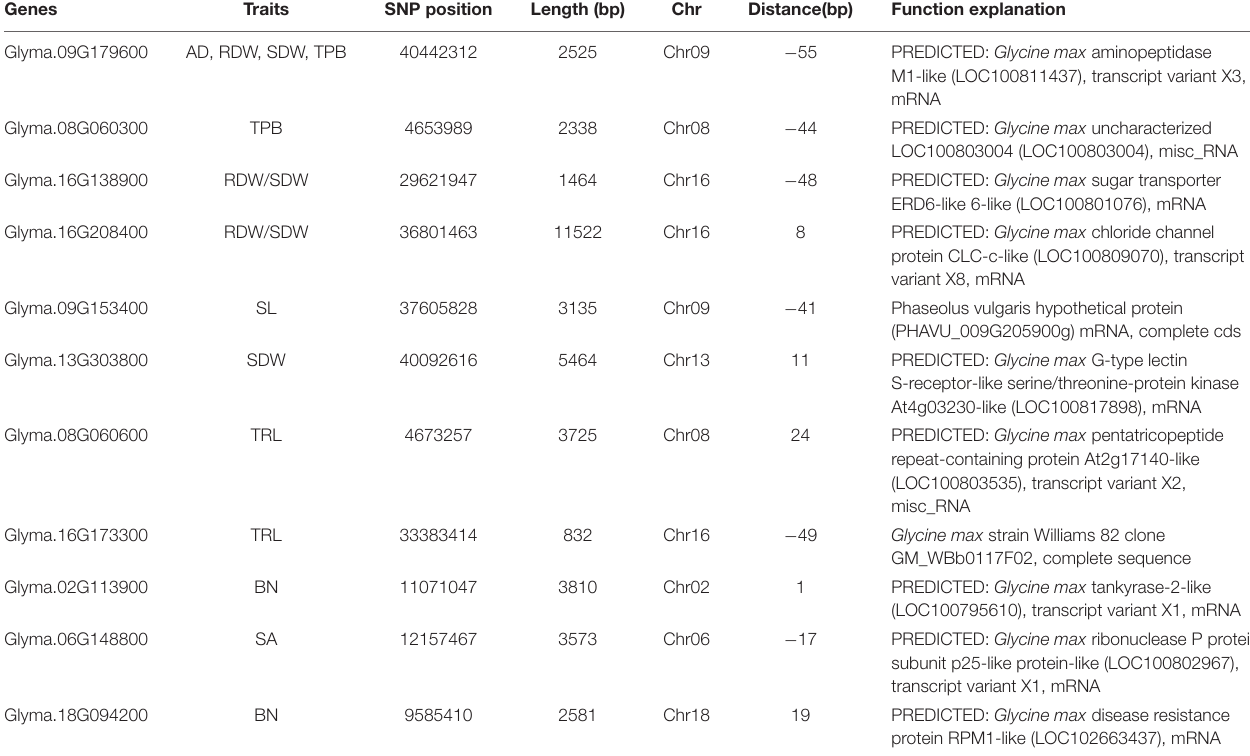
FIGURE 4 | (A) The number of SNPs detected by different methods and (B) different combinations of methods. Method numbers correspond to (1) GLM, (2) MLM, (3) CMLM, (4) FaST-LMM, and (5) EMMAX. TABLE 5 | Potential candidate genes identified through GWAS and their functional